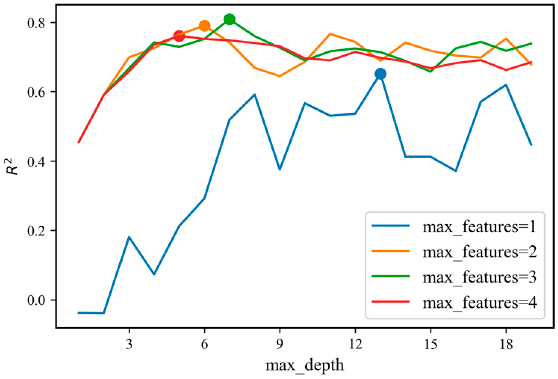
Figure 6. Determination of hyper-parameters for DT model.